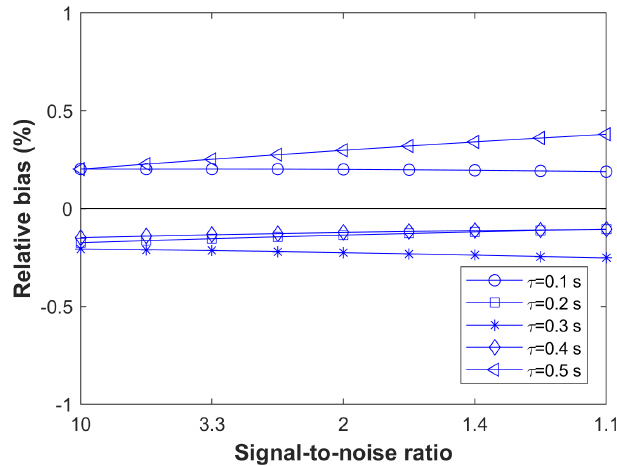
Figure 9. Relative biases of the cumulative fluxes derived with the CSA √ compared with the reference flux as a function of SNR H, sync for different attenuation timescales (0.1–0.5s), calculated as, for ex- − F REF )/F REF ample, 100 (F CSA √ H, sync